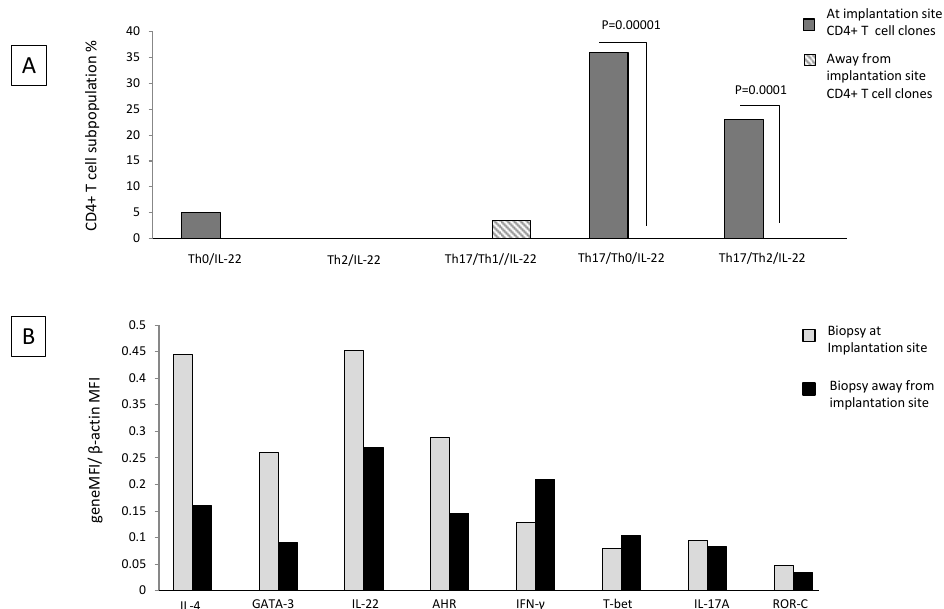
Figure 6. Th17/Th2/IL-22+ and Th17/Th0/IL-22+ CD4+ T cells are exclusively present at the implantation site of ectopic pregnancy. The percentages of Th0/IL-22+, Th2/IL-22+, Th17/Th0/IL-22+, Th17/Th2/IL-22+, and Th17/Th1/IL-22+ cells among the CD4+ T cell clones respectively derived from the implantation site of the embryo and distant from the implantation site in the same Fallopian tube of four women suffering from ectopic pregnancy were evaluated (Experiment 2 according to Section 4.3).